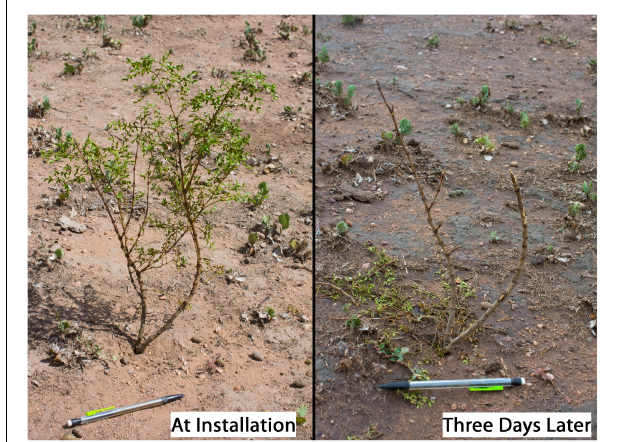
FIGURE 2 | Simulated velvet mesquite ( Prosopis velutina ) sapling (approximately 30 cm in height) upon installation on an active black-tailed prairie dog ( Cynomys ludovicianus ) colony (left) vs. after 3 days of exposure to black-tailed prairie dogs (right) .